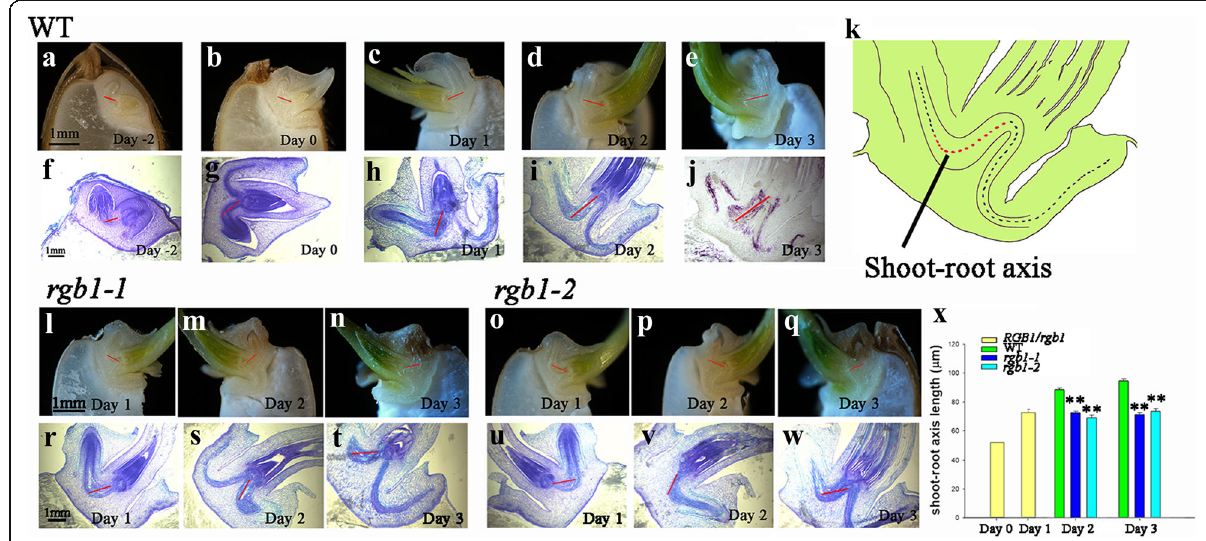
Fig. 5 RGB1 positively regulates shoot-root axis development in embryos during the early postgermination stage. (The red line indicates the location of the shoot-root axis.) a-e Median longitudinal sections and sections of WT embryos ( a ) soaked in distilled water for 1 day (day − 2), b soaked in distilled water for 3 days (day 0), c at 1 day after germination, d at 2 days after germination, and ( e ) at 3 days after germination. f-j Median longitudinal sections and sections of WT embryos ( f ) soaked in distilled water for 1 day (day − 2), g soaked in distilled water for 3 days (day 0), h at 1 day after germination, i at 2 days after germination, and ( j ) at 3 days after germination. k Diagram showing the location of shoot- root axis length (red dotted line). l-q Median longitudinal sections of rgb1 embryos at 1, 2, and 3 days after germination. r-w Median longitudinal sections of rgb1 embryos at 1, 2, and 3 days after germination. x Shoot-root axis lengths of the rgb1 mutant, RGB1 heterozygote, and WT at 0, 1, 2, and 3 days after germination. The data are means ± SDs (n = 10; ** p <